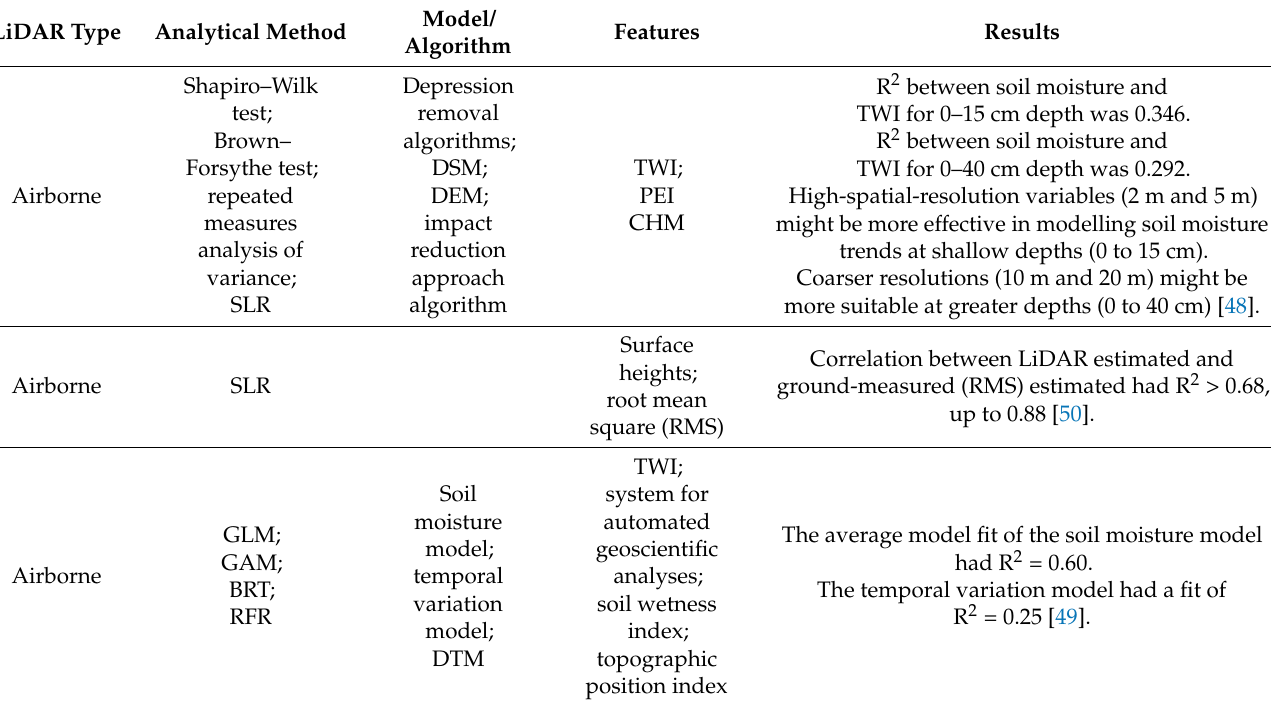
Table 7. Comparison of various aspects of LiDAR data in soil property